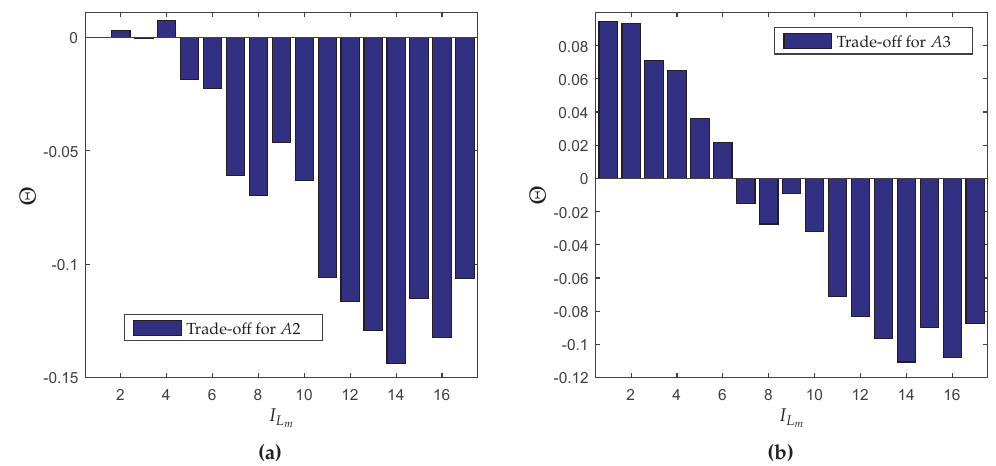
Figure 10. Trade-off ( Θ ) of the system evaluated in terms of the distinct network settings ξ according with I Lm for: ( a ) the second approach ( A 2 with L 8,5 L ∈ { }